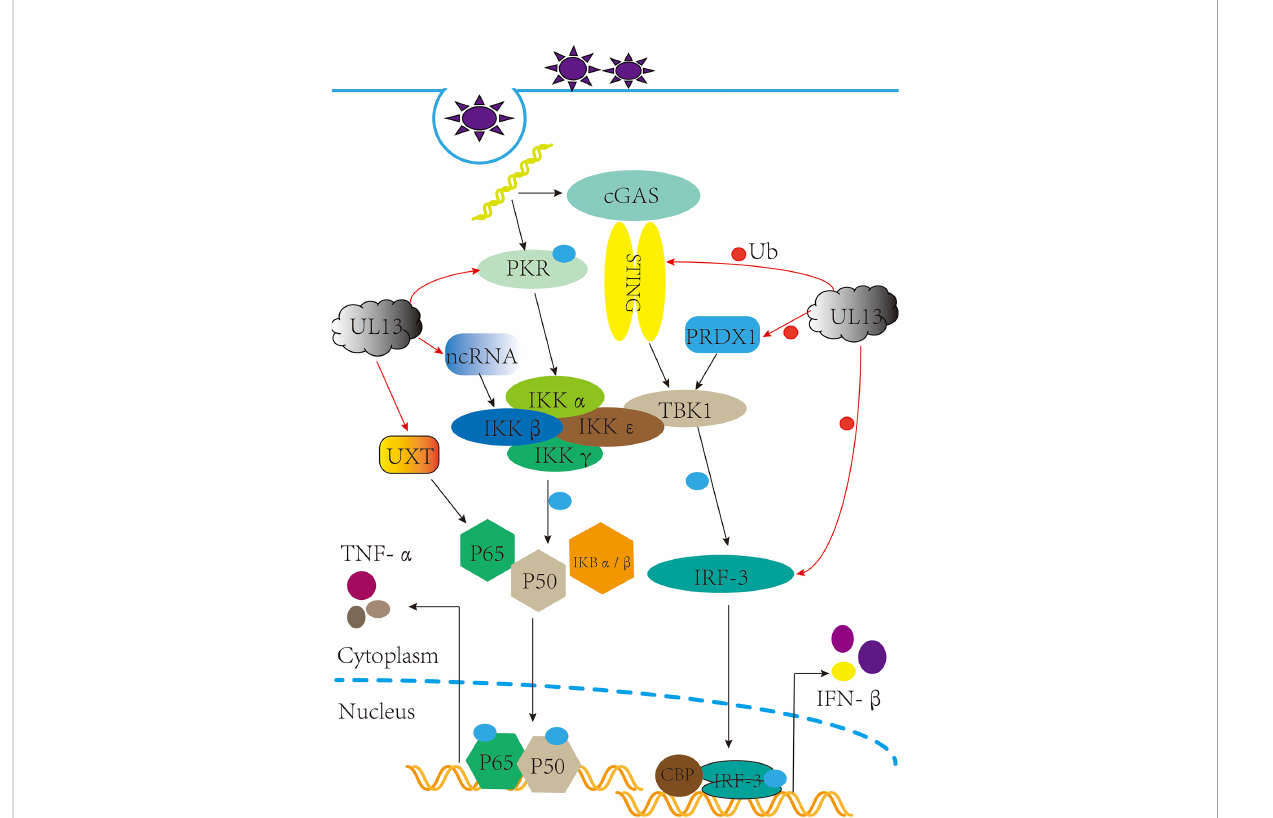
FIGURE 1 pUL13 inhibits the cGAS-STING signaling pathway and the NF- k B signaling pathway. pUL13 can inhibit the dimerization, nuclear translocation, CBP binding, and binding to IFN- b promoter elements of interferon regulatory factor 3 (IRF3); meanwhile, it can ubiquitinally degrade stimulator of interferon genes (STING), IRF-3, and peroxidase 1 (PRDX1) to inhibit the production of IFN- b . pUL13 indirectly inhibits the NF- k B pathway by regulating ubiquitously expressed transcript (UXT), Protein kinase R (PKR), and B2 SINE